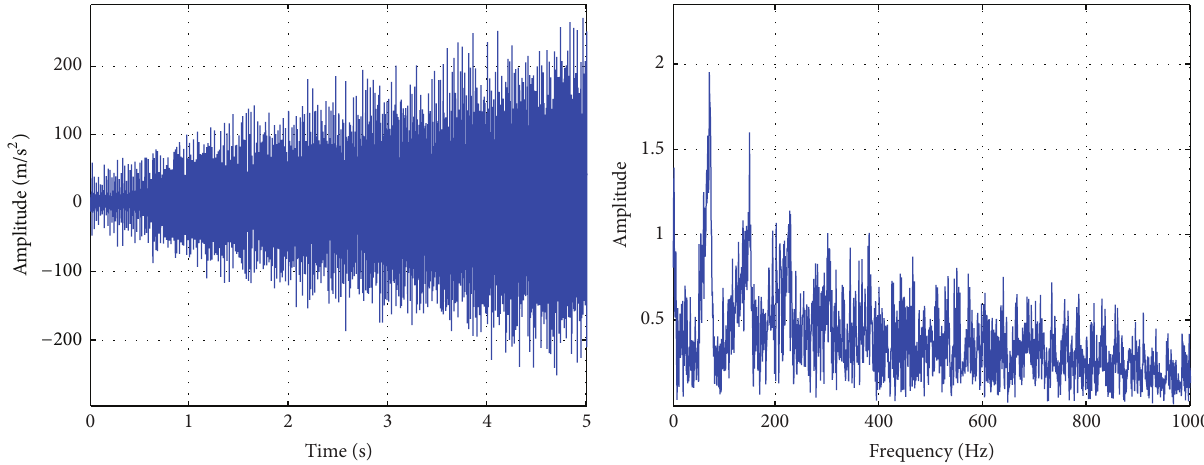
Figure 4: Vibration signal and envelope power spectrum under variable speed.